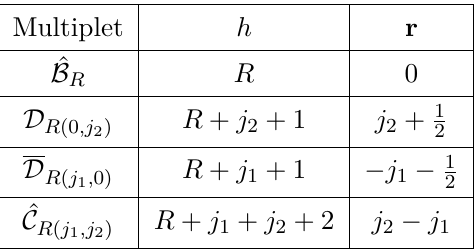
Table 4 . List of 4d N = 2 superconformal multiplets that contain Schur operators (one for each multiplet). Here R and ( j ) denote the Cartan of the SU(2) 1 , j 2 quantum numbers of the superconformal primary of the multiplet, while h is the chiral dimension and r the U(1) charge of the Schur operator. In our conventions, R , j r half-integer values. Even and odd values of 2 r correspond to bosonic and fermionic Schur operators,